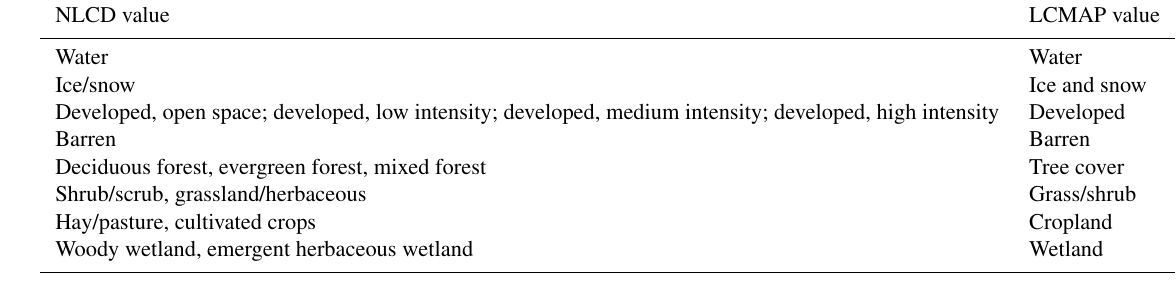
Table 2. NLCD land cover cross-walked to LCMAP land cover.